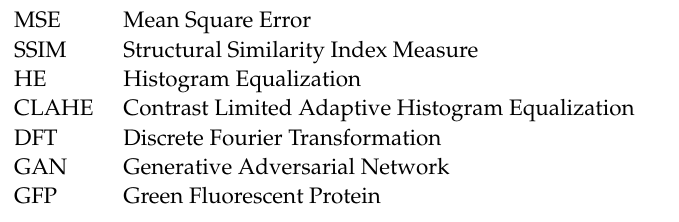
Figure S12: The calculated wavelength in a movie. Table S1: Hyperparameter optimization. Table S2: Hyperparameter optimization after histogram equalization. Video S1: Aggregate Segmentation. Video S2: Model